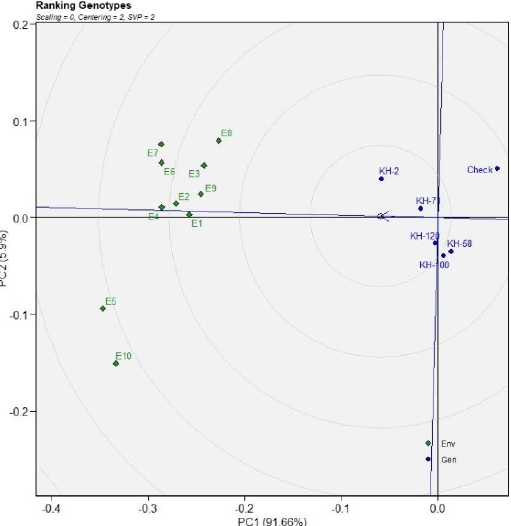
Figure 6. ( A ) AMMI1 biplot ( B ) AMMI2 biplot of EO yield of five selected accessions and the check variety of C. caesia germplasm for eleven environments.